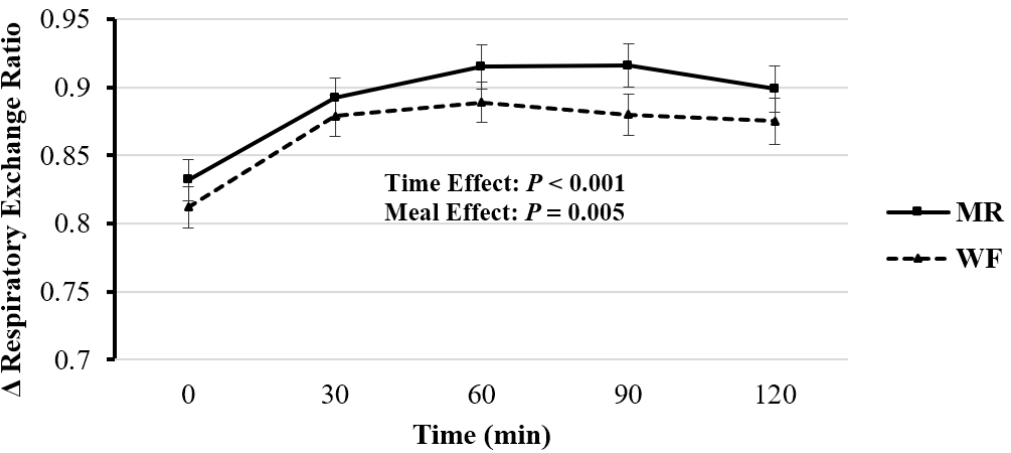
Figure 3. Postprandial change in respiratory exchange ratio 120 min for each meal. MR: Meal replacement meal; WF: Whole food meal. Data displayed as mean ± standard error.